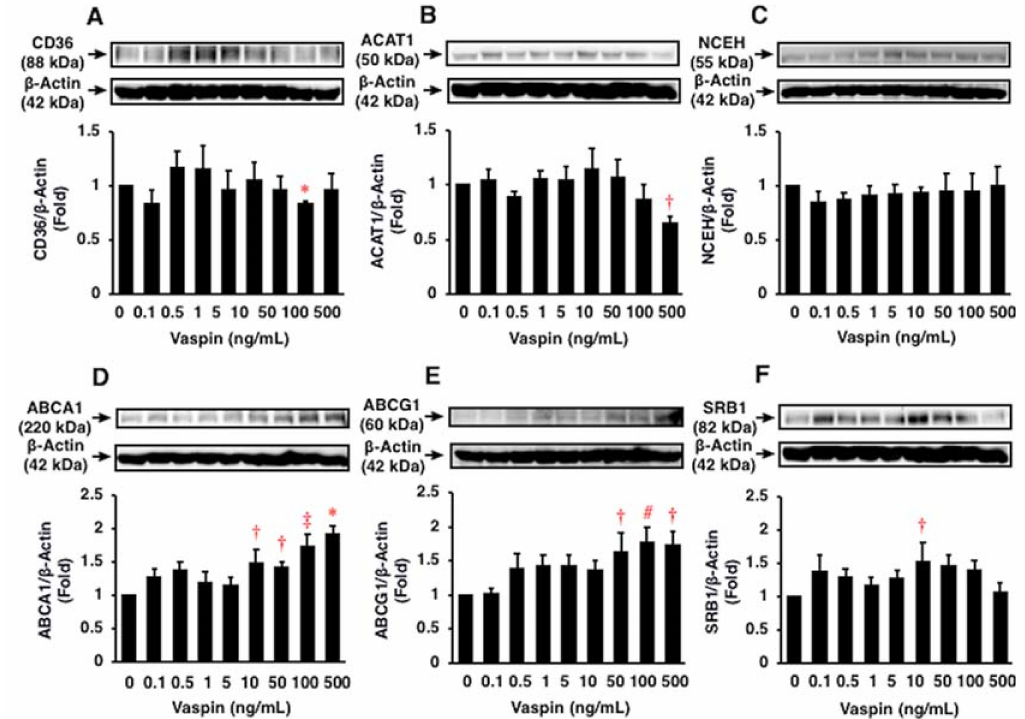
Figure 3. Effects of vaspin on foam cell formation related protein expression in THP1 monocyte-derived macrophages were assessed by immunoblotting. The blotted membranes were cut for reacting with different antibodies, and the blots were stripped and reprobed in the same membrane. Top: Representative results of protein expression of each CD36 ( A ), ACAT1 ( B ), NCEH ( C ), ABCA1 ( D ), ABCG1 ( E ), and SRB1 ( F ). Bottom: Densitometric data of each molecule after normalization relative to β -actin ( n = 5–6). * p < 0.0001, † p < 0.05, ‡ p < 0.001, # p < 0.01 vs. 0 ng/mL of